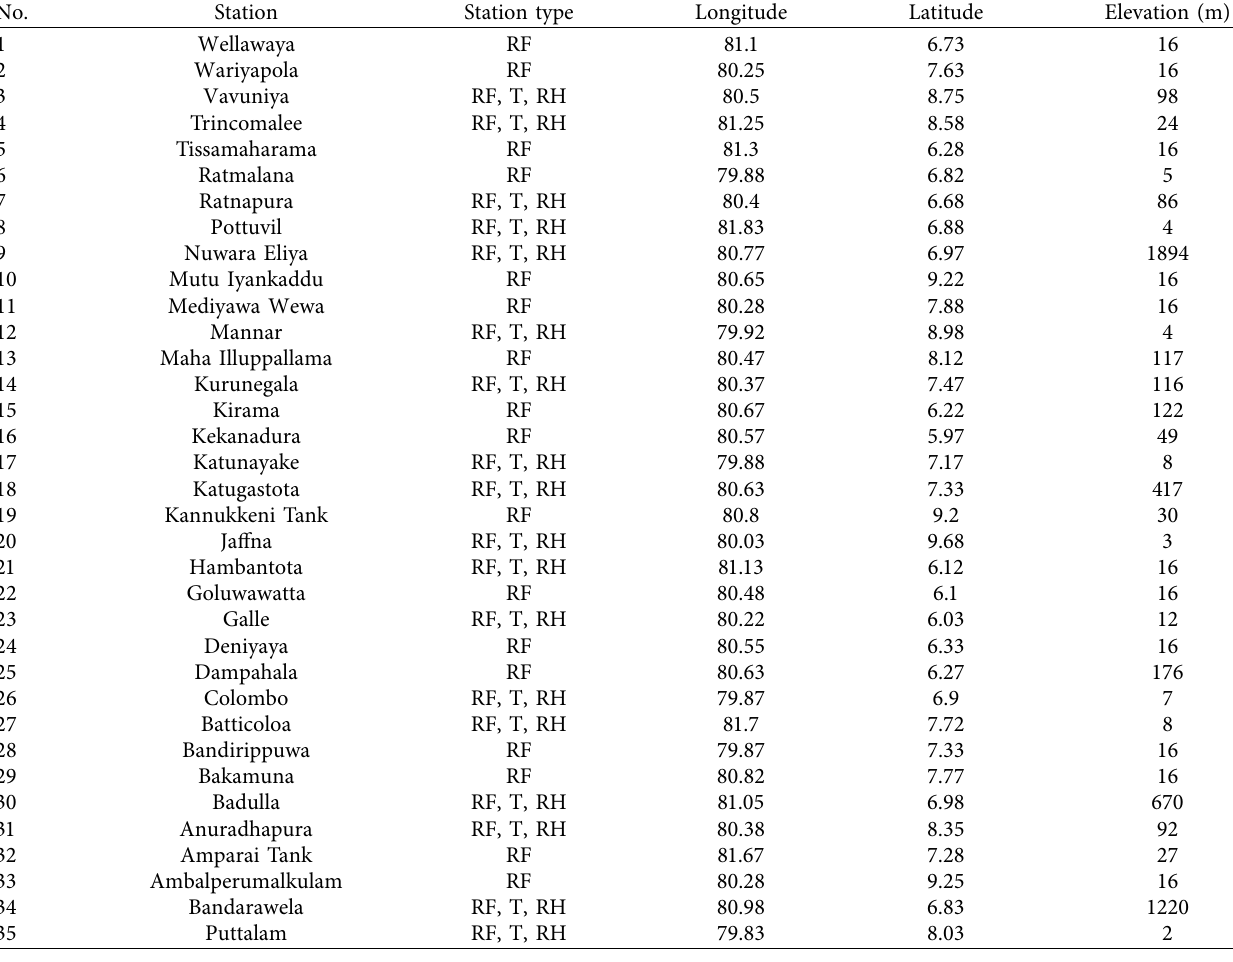
Table 1: List of meteorological stations and their